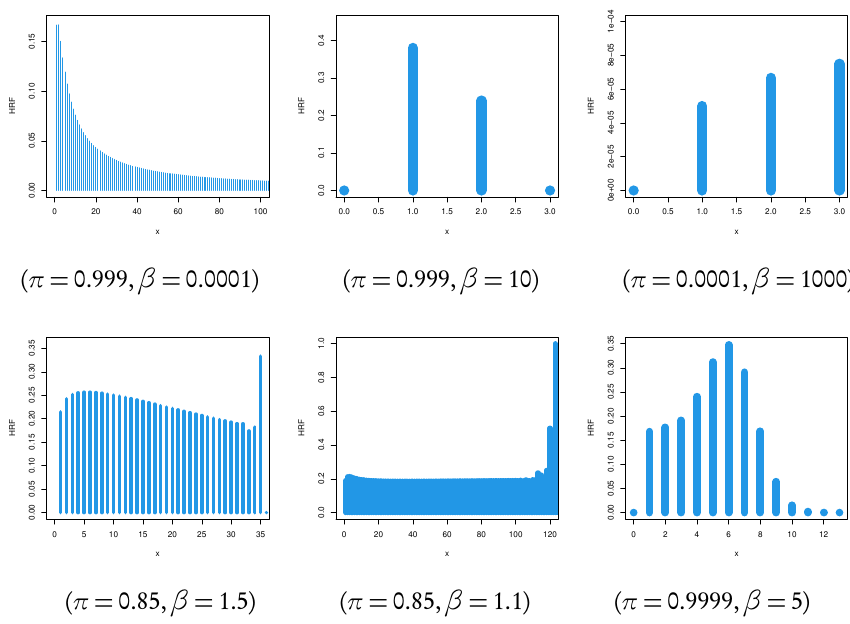
Figure 2 – The HRF plots of the DGBH